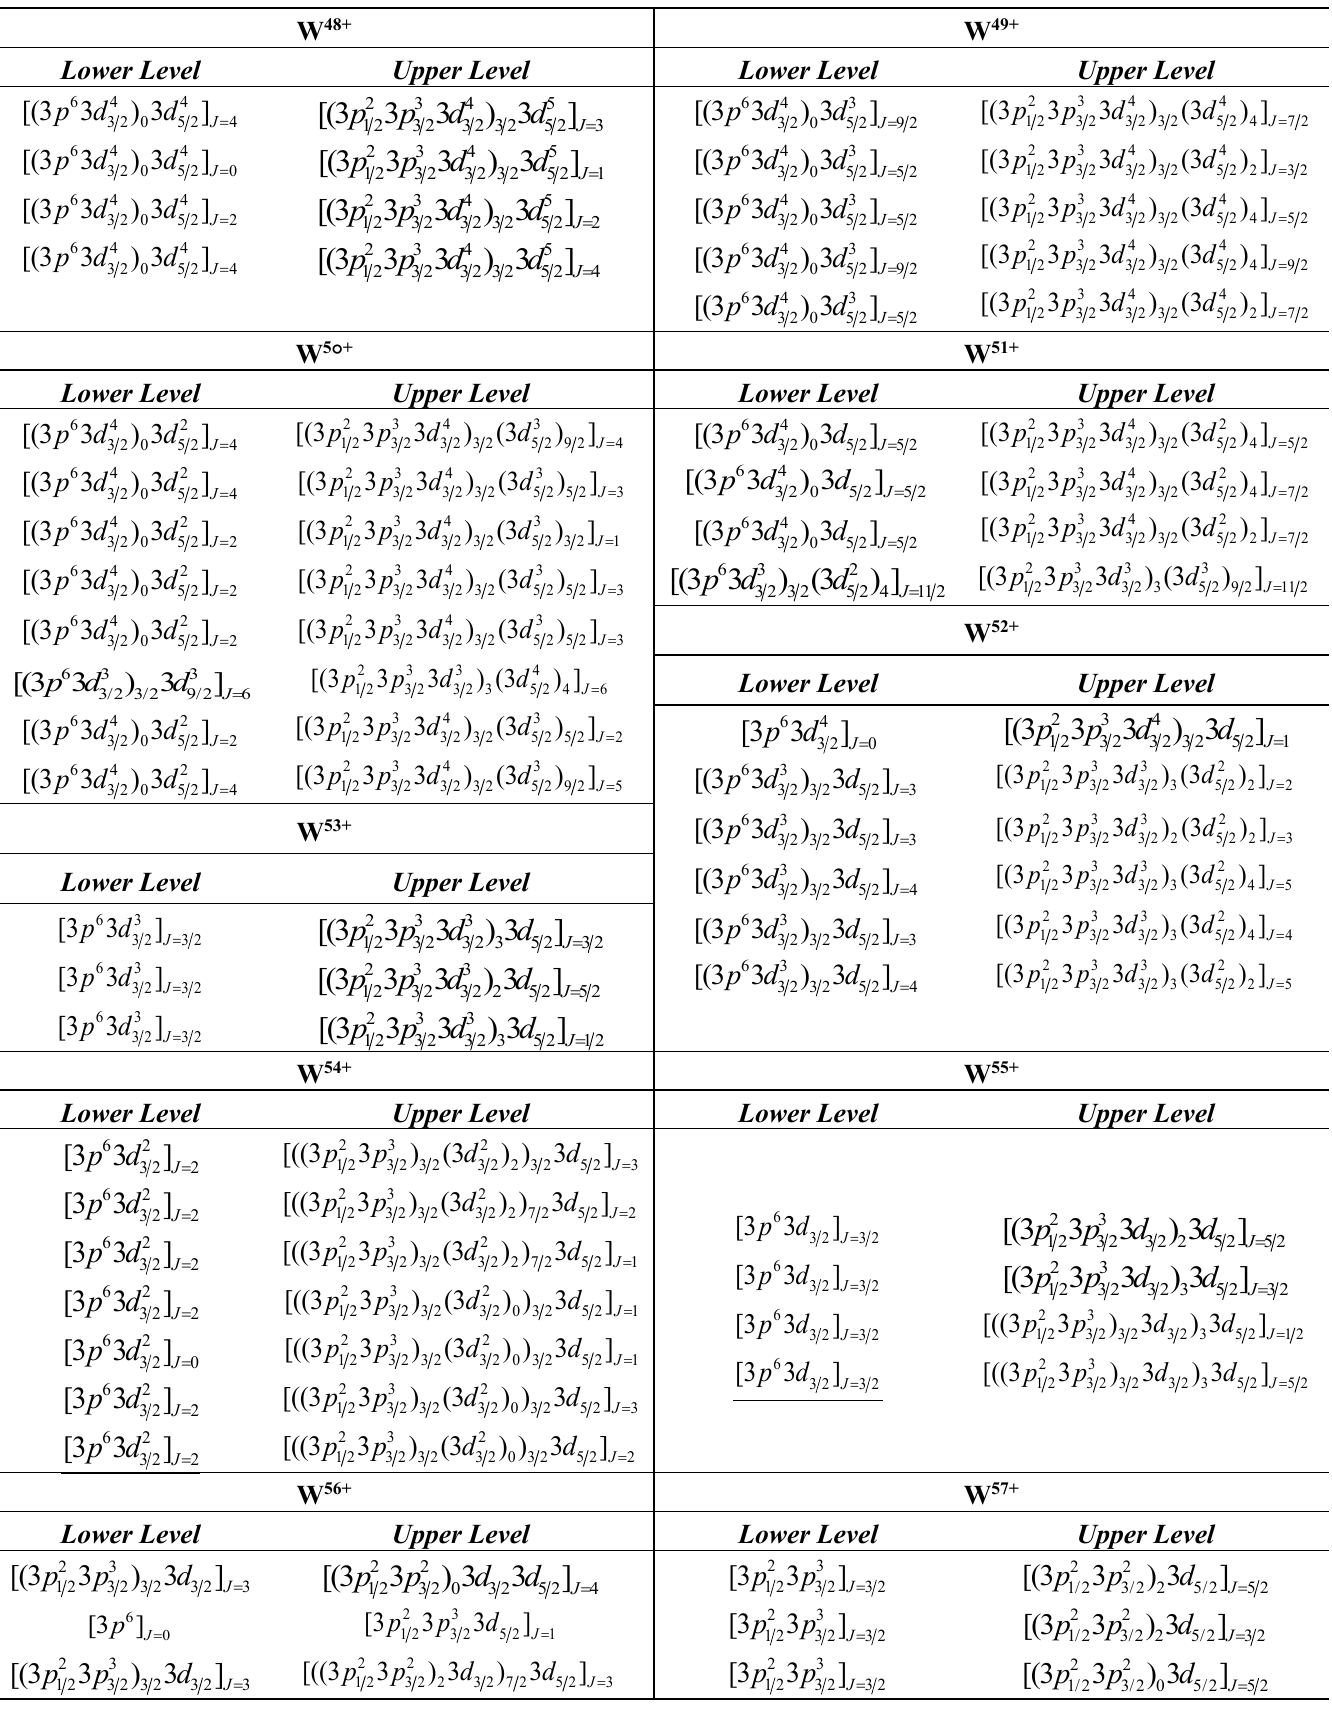
Table 4. M-shell excitations considered in Fe-like W 48+ through Al-like W 61+ ions [27]. W 48+ W 49+ Lower Level Upper Level Lower Level Upper